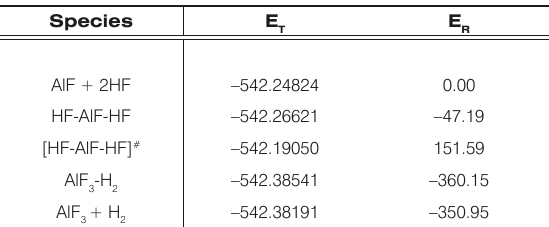
Table 6. CCSD(T)/6-311G(d,p)//B3LYP/6-311G(d,p) + ZPE Total Energies E (a.u.) and Relative Energies E T the reaction AlF + HF (reaction channel